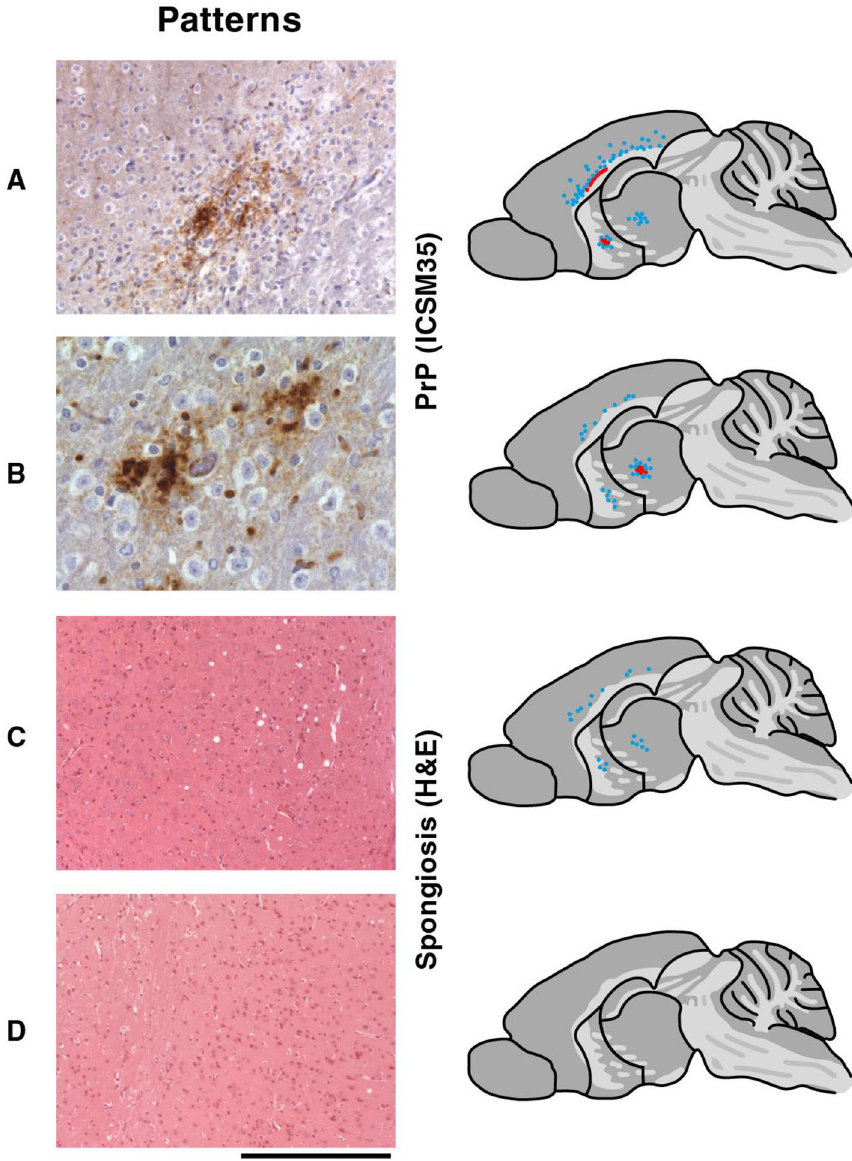
Figure 1. Distribution of spontaneous abnormal PrP and spongiform change in the brain of aged Tg20 mice challenged with D-PBS or buffer: The left hand panels show the typical histology which is the predominant feature of each group. ( A and B ) PrP immunohistochemistry using anti-PrP monoclonal antibody ICSM35 revealed abnormal PrP deposition including PrP-positive plaques. ( C and D ) Haematoxylin and eosin (H&E) stained sections showing spongiform neurodegeneration when present. Scale bar: 150 µm ( A ), 75 µm ( B ), and 300 µm ( C and D ). The right hand panels show schematic representations of mouse brain and indicate the spatial distribution of the pathology typical for each group. Abnormal PrP deposition is indicated in red and spongiform degeneration in